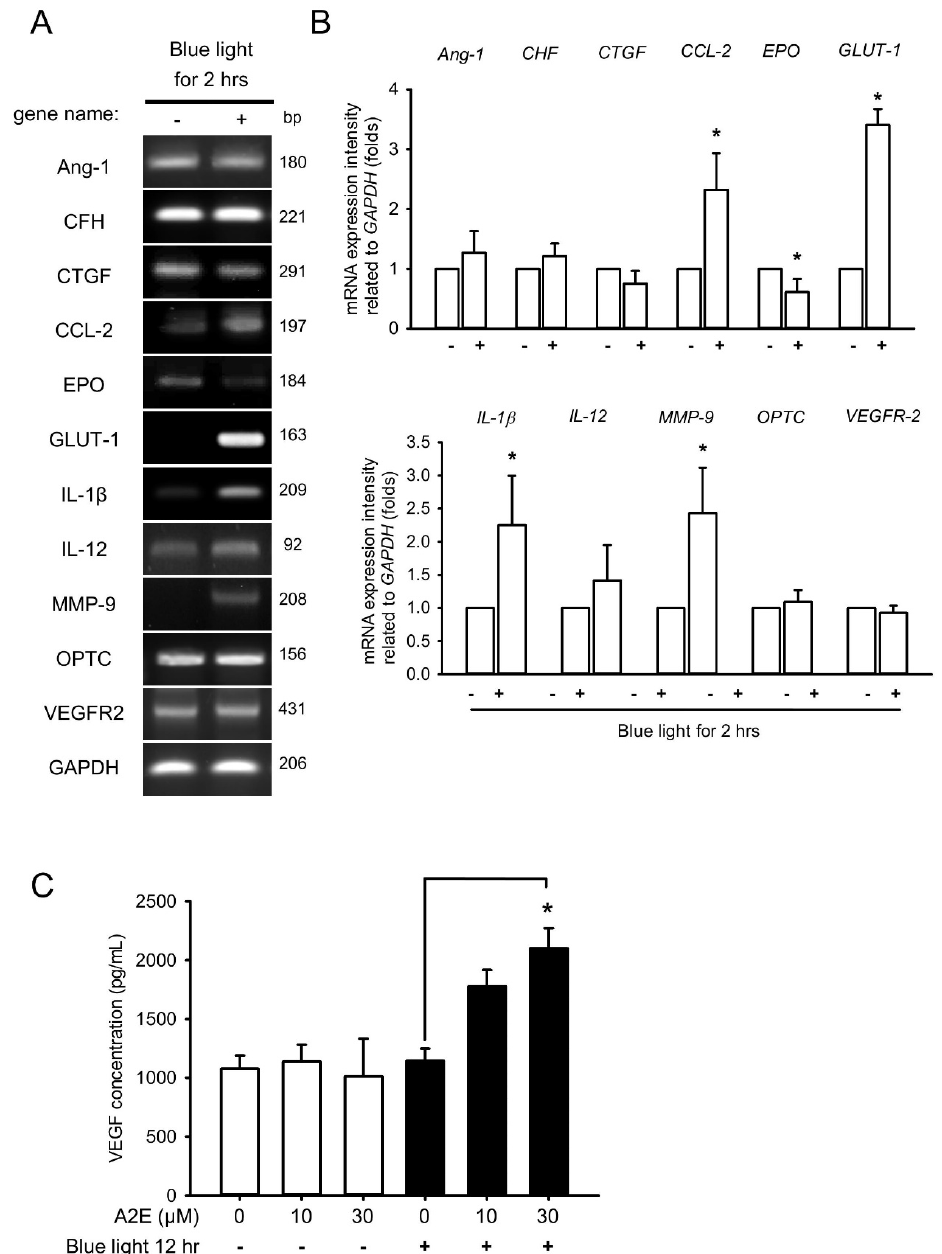
Figure 4. Blue light induces inflammatory and angiogenic gene expression in early stages and increases vascular endothelial growth factor (VEGF) secretion in A2E-laden retinal pigment epithelial RPE cells. ( A ) RPE cells were pretreated with 30 µ M A2E for 12 h and then exposed to blue light-emitting diode (LED) light (BLL) for 0 and 2 h (460 nm, 150 lux). Angiopoietin-1 ( Ang-1 ), complement factor H ( CFH ), interleukin 1 beta ( IL-1 β ), IL-12 , connective tissue growth factor ( CTGF ), C-C motif chemokine ligand 2 ( CCL-2 ), erythropoietin ( EPO ), glucose transporter 1 ( GLUT-1 ) , matrix metalloproteinase-9 ( MMP-9 ), opticin ( OPTC ), VEGF receptor 2 ( VEGFR-2 ), and glyceraldehyde 3-phosphate dehydrogenase ( GADPH ) mRNA levels were detected by RT-PCR. ( B ) Quantification of mRNA levels relative to the GAPDH control was performed via densitometry and expressed as means ± SE. Results from 3 independent experiments are shown (N = 3). * p < 0.05 was considered statistically significant compared to controls. ( C ) The level of VEGF secretion in A2E-laden RPE cells was quantified via enzyme-linked immunoassay (ELISA). RPE cells were loaded with 0, 10, and 30 µ M A2E for 12 h (white bars) or co-treated with A2E and blue light-emitting diode (LED) light (BLL) for 12 h (460 nm, 150 lux) (black bars). VEGF secretion increased in A2E-laden RPE cells after BLL exposure. Results from 4 independent experiments are shown (N = 4). * p < 0.05 was considered statistically significant compared to